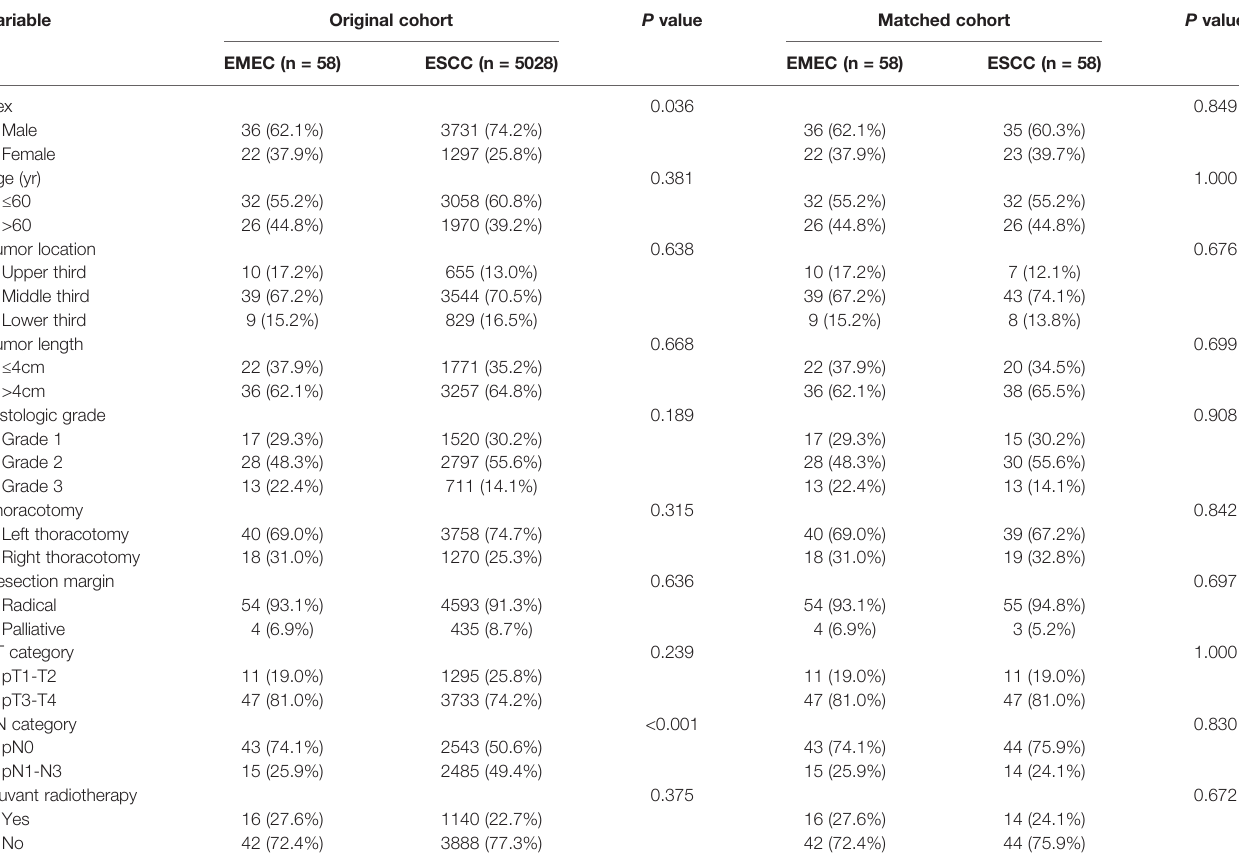
TABLE 2 | Clinicopathological features between patients with EMEC and ESCC in the original cohort and matched